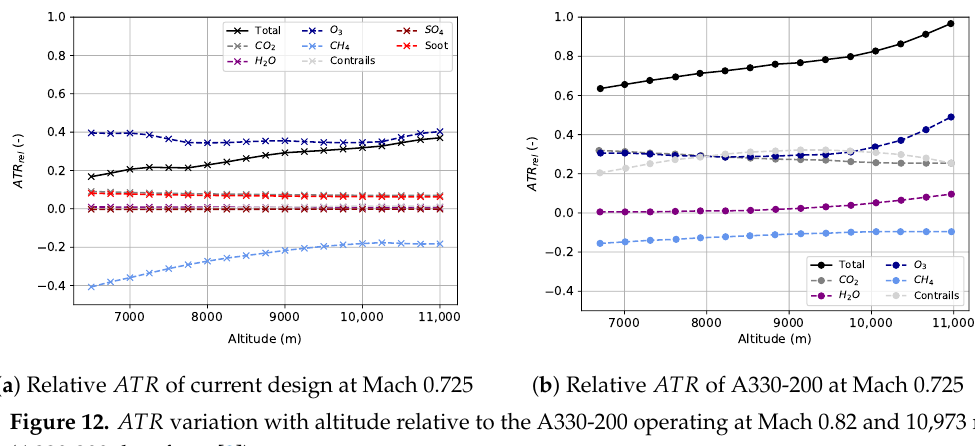
Figure 12. ATR variation with altitude relative to the A330-200 operating at Mach 0.82 and 10,973 m (A330-200 data from [2]).